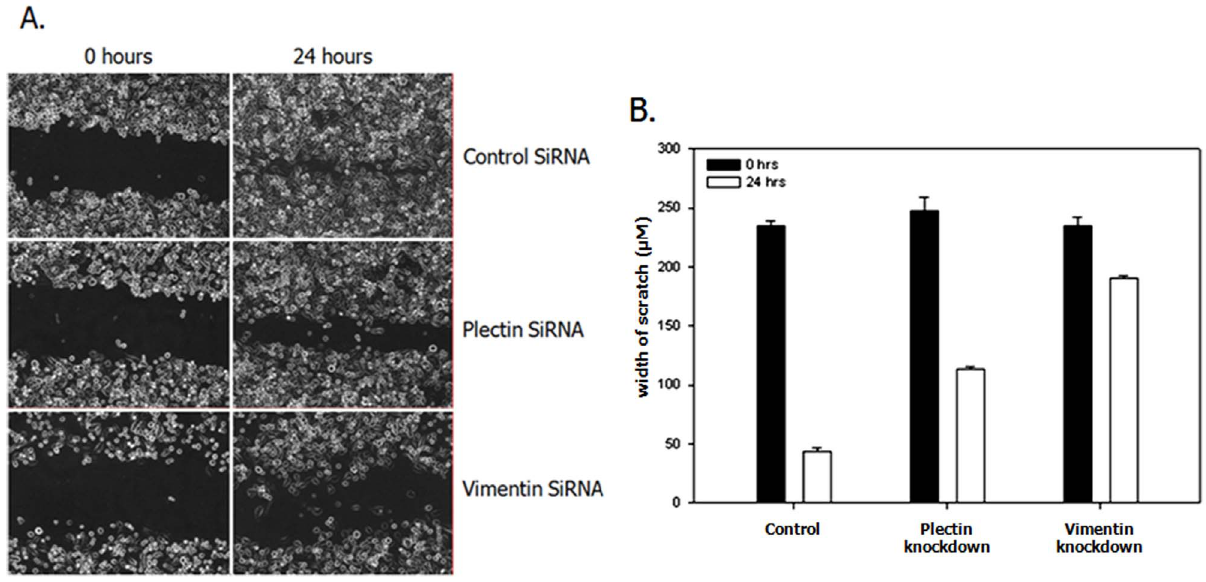
Figure 6. Plectin and vimentin suppression significantly reduces the migration ability of PC3-ML2 cells. A. Confluent monolayer PC3- ML2 cells were scratched with a pipette tip and migration toward the wounded area was observed and measured. B. There is a significant difference in the migration rates between control siRNA compared with plectin and vimentin siRNA, P , 0.05.